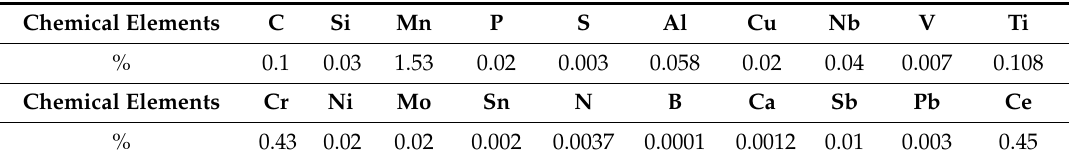
Table 1. The chemical composition of LNE 700 steel.